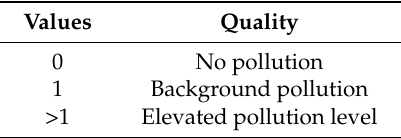
Table 3. Pollution load index (PLI) criterion.